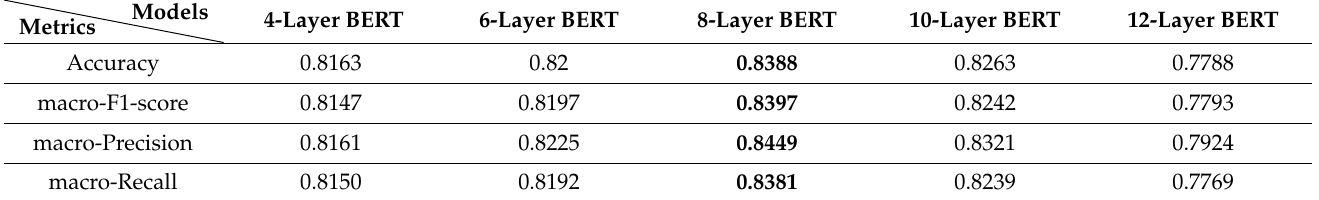
Table 2. Classification performance of models with different BERT layers—sample size=0.4, pre-training epoch = 200.